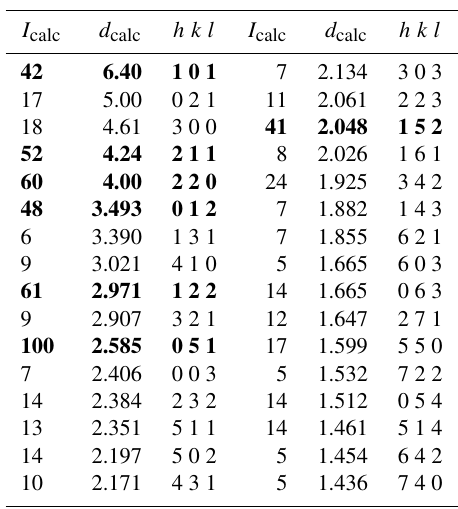
Table 9. X-ray powder diffraction data ( d in Å) for dutrowite. In- tensity and d hkl were calculated using the software PowderCell 2.3 (Kraus and Nolze, 1996) on the basis of the structural model given in Table 5. Only the reflections with I calc > 5 are given. The seven strongest reflections are given in